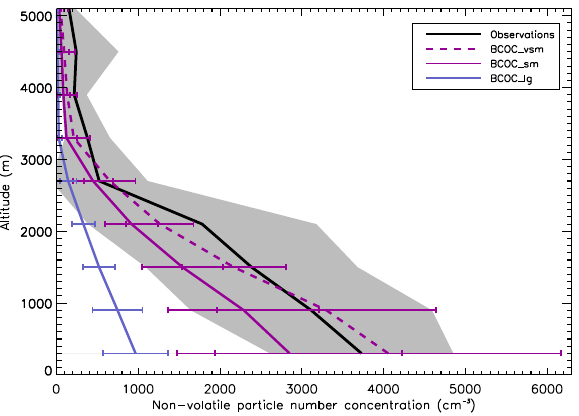
Fig. 10. Mean number size distributions of measured non-volatile particles (black) and of modelled carbonaceous particles (colour) for all flight hours with a mean altitude less than 2km a.s.l. The to- tal modelled size distribution of BC particle cores is shown in bold and the modelled size distribution of aged BC+OC (with condensed SO 4 and SOA) is shown for sizes larger than ∼ 100nm. The er- ror bars and shading represent the standard deviation of the model and observations, respectively. Model experiments, BCOC lg and BCOC sm, are described in Table